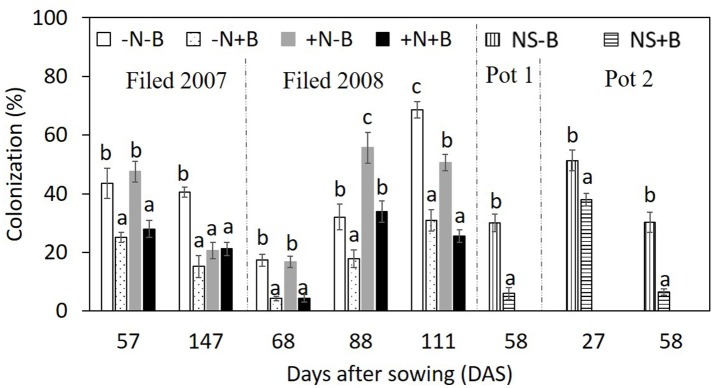
Effects of N fertilizer supply and benomyl on colonization by maize at different growth stages in the field experiment in 2007 and 2008, and in the pot experiment 1 and 2. Each value is the mean of four replicates (±SE). Different letters denote significant difference (P < 0.05) among the treatments at each growth stage. –N–B: no N fertilizer and no benomyl; –N+B: no N fertilizer and benomyl; +N–B, N fertilizer and no benomyl; +N+B, N fertilizer and benomyl. DAS: days after sowing for years 2007 (2008) [57 (68) = jointing; 88 = silking; 111 = milk: 147 = harvest]; NS–B: non-sterilized soil and no-benomyl; NS+B: non-sterilized soil and benomyl in Pot 1 and 2.